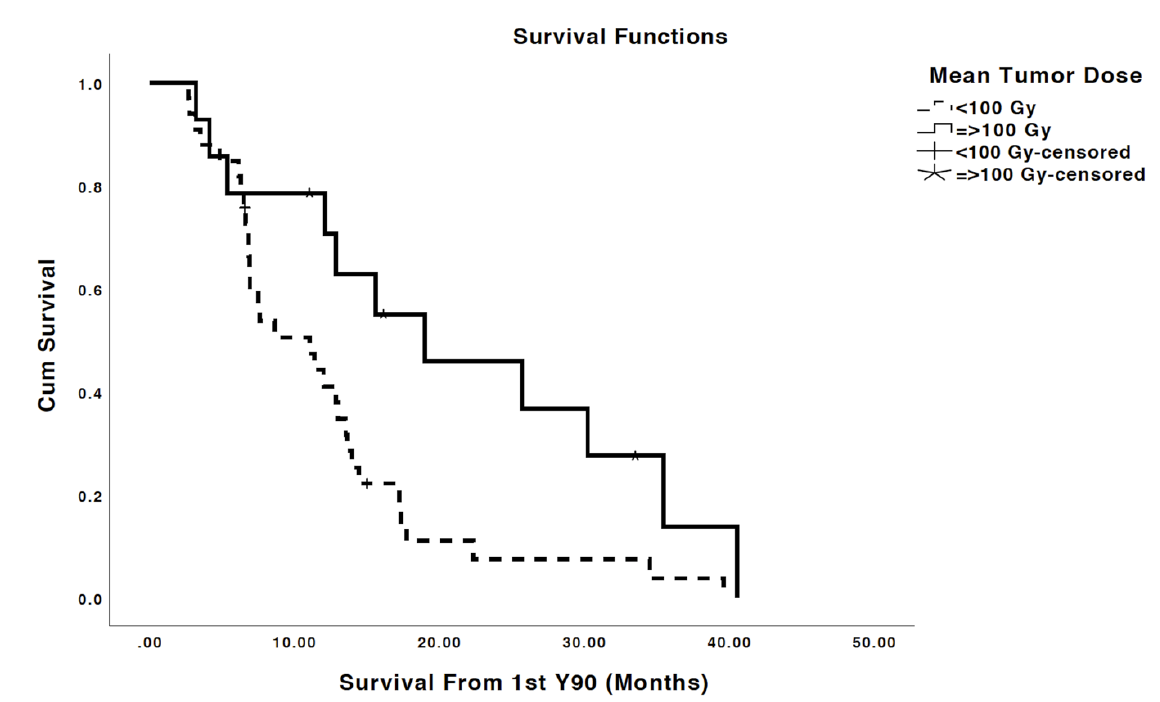
Figure 3. Patients who received mean TD ≥ 100 Gy had a median OS of 19 months compared to 11 months for those receiving less ( p = 0.016).